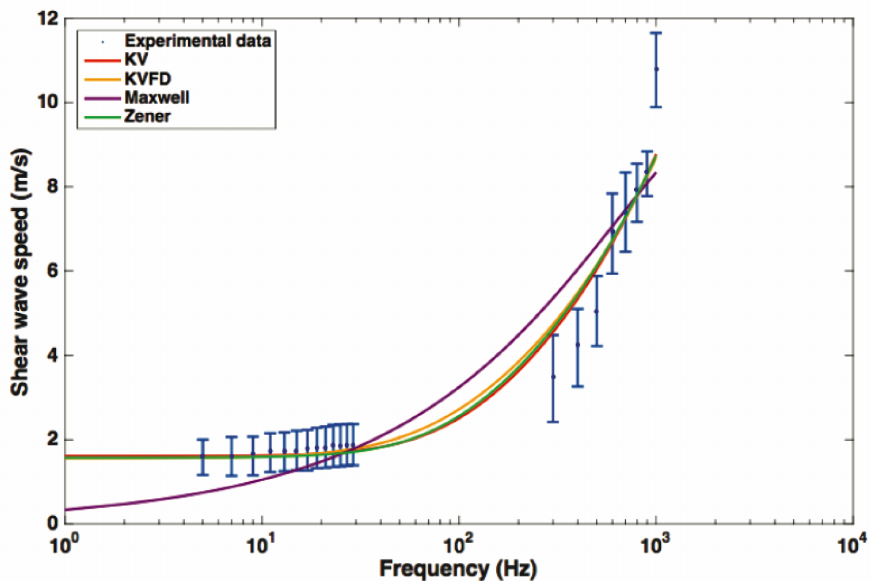
Figure 6. Fitting of the most popular rheological models to the experimental results obtained by rheometry (the lowest frequencies) and TWE (the highest frequencies) in the cervix Ex vivo. The Kelvin–Voigt (KV), Kelvin–Voigt fractional derivative (KVFD) and Zener models are successfully adjusted while the Maxwell model is not able to represent the full frequency range satisfactorily. Source: Sensors, reproduced from 2017 Callejas et al.